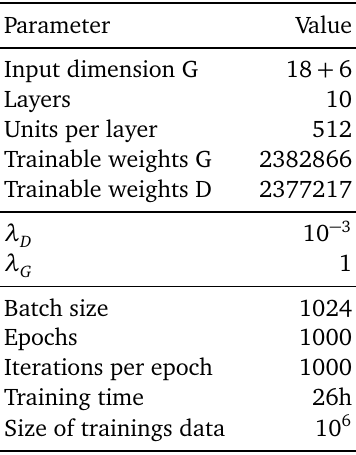
Table 1: Details for our GAN